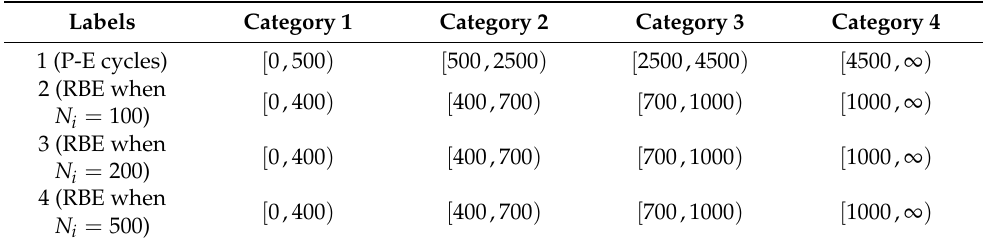
Table 2. The labels and